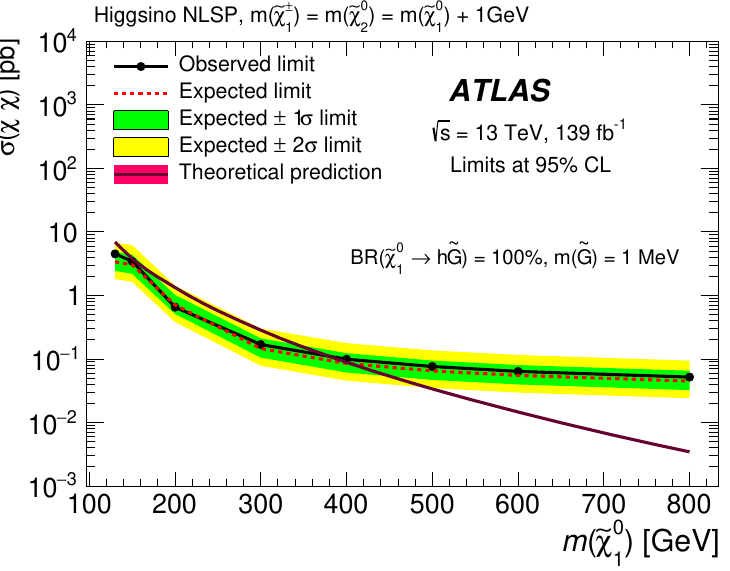
Figure 11 . Expected and observed 95% CL exclusion upper limits on the higgsino production (~ (cid:31) ~ (cid:31) (cid:17) ~ (cid:31) 0 ~ (cid:31) 0 ; ~ (cid:31) 0 ~ (cid:31) (cid:6) ; ~ (cid:31) 0 ~ (cid:31) (cid:6) ; ~ (cid:31) (cid:6) ~ (cid:31) (cid:7) ) cross-section for the h ~ Gh ~ G signal model. As a function of the 1 2 1 1 2 1 1 1 higgsino mass. The theoretical prediction includes the ~ (cid:31) 0 modes, where ~ (cid:31) (cid:6) and ~ (cid:31) 0 promptly decay into the ~ (cid:31) 0 1 2 to be